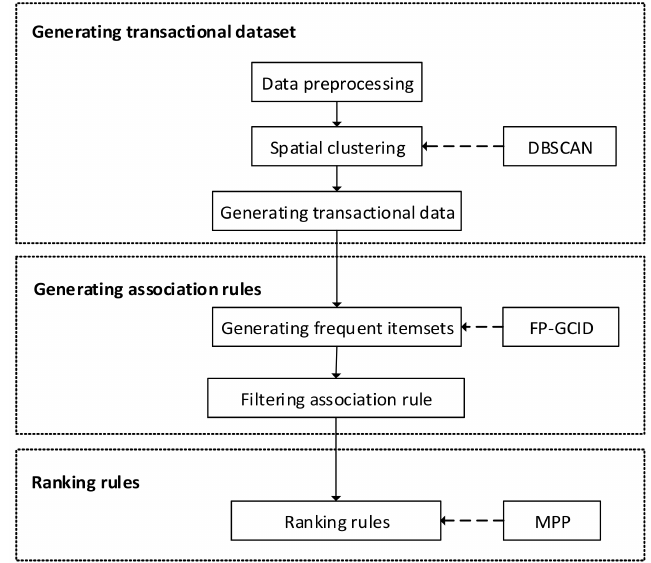
Figure 3. Experimental procedure. MPP: Mean-Product of Probabilities; DBSCAN: Density-Based Scanning Algorithm with Noise.